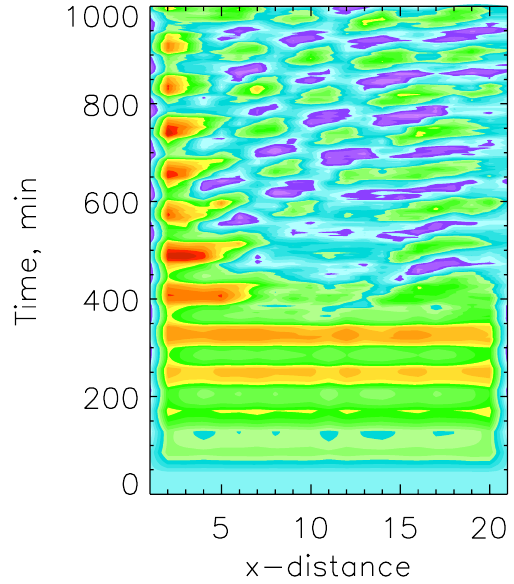
Fig. 10. Two-dimensional simulations (21 × 21 oscillators) with τ c = 43min (2 × T ), η = − 0 . 20 ± 0 . 03 and H 0 = 670m ± 100m. The display shows contours of H i,j as a function of i ( x distance; abscissa) and time (ordinate). The linear colour scale is from 0 to 800m (purple through red/brown) Model output has been averaged over all j -grid points. Prior to about 300min the all components are synchronized and rise and sink in unison (see also Fig. 11). There- after, the spatial symmetry is broken by the onset of rain and a grid- ded structure merges depicting spatiotemporal oscillations in H i,j .